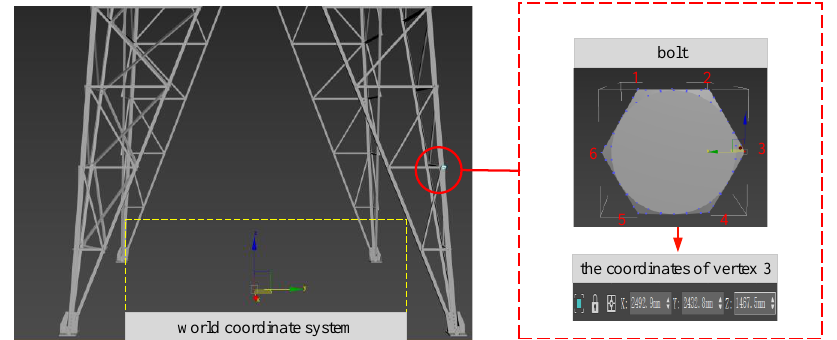
Figure 3. Coordinate information of the bolt